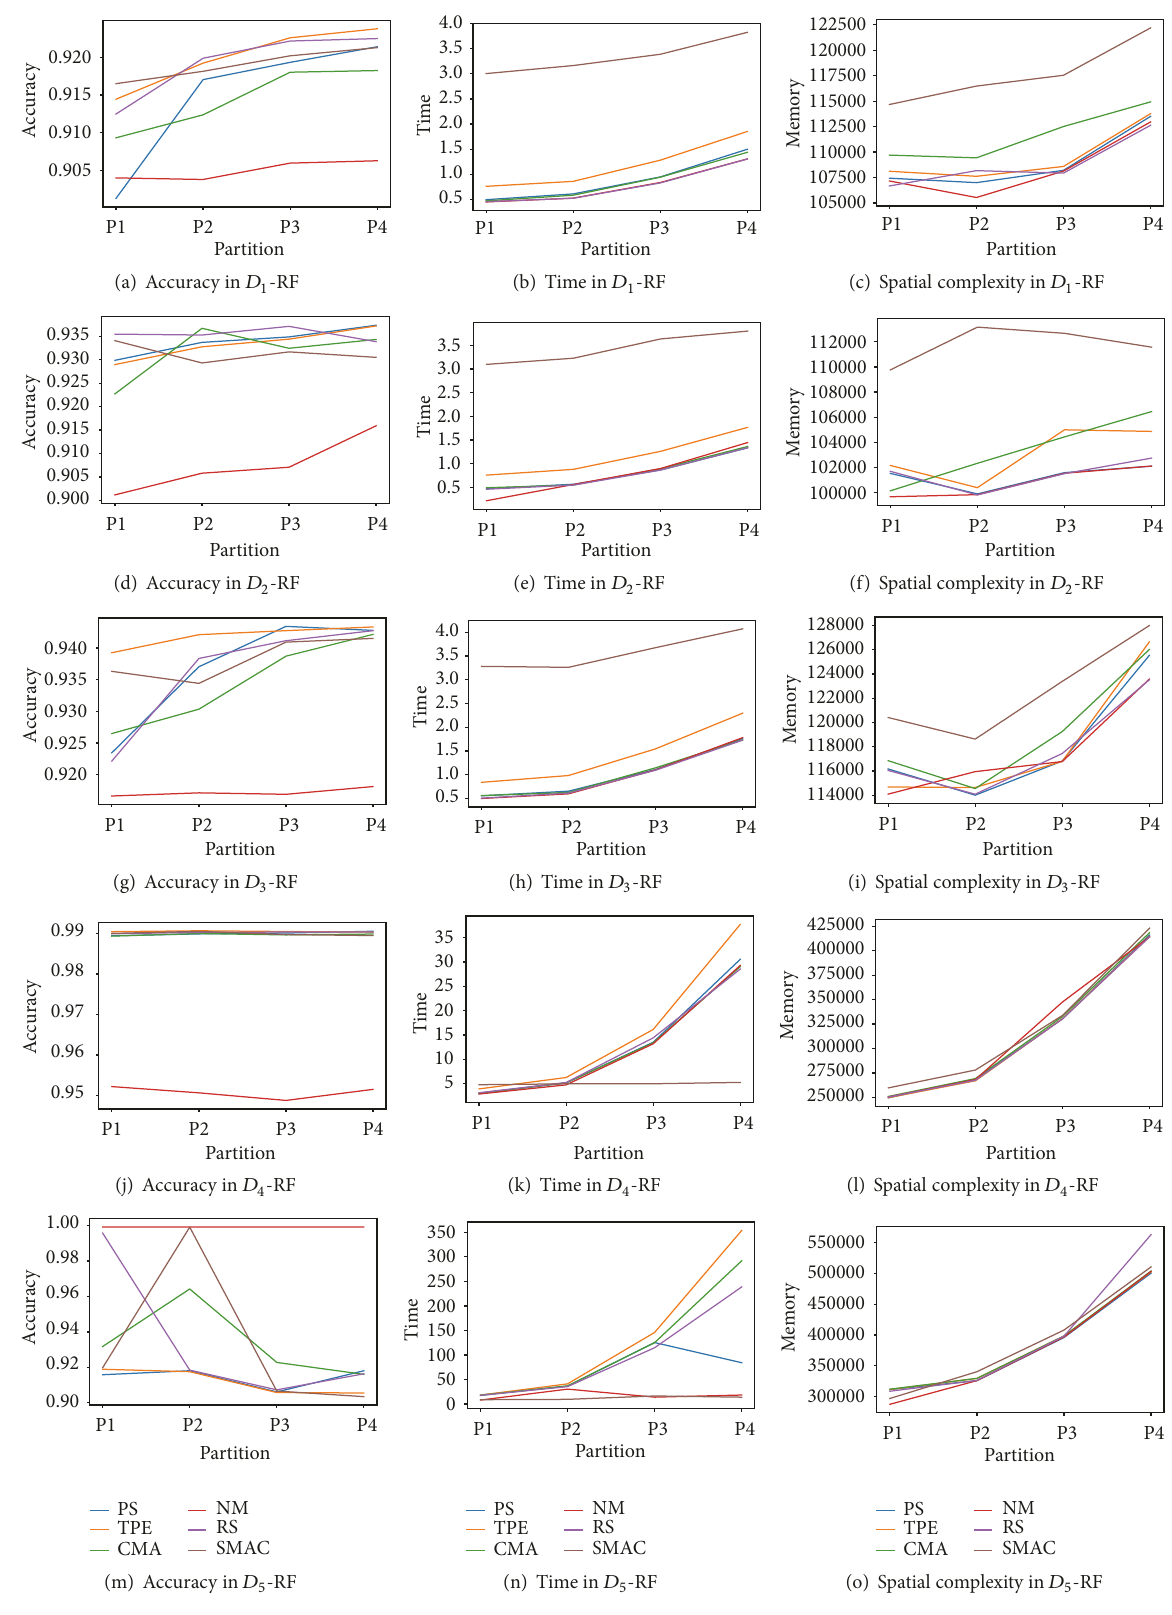
Figure 1: Accuracy, time, and spatial complexity of